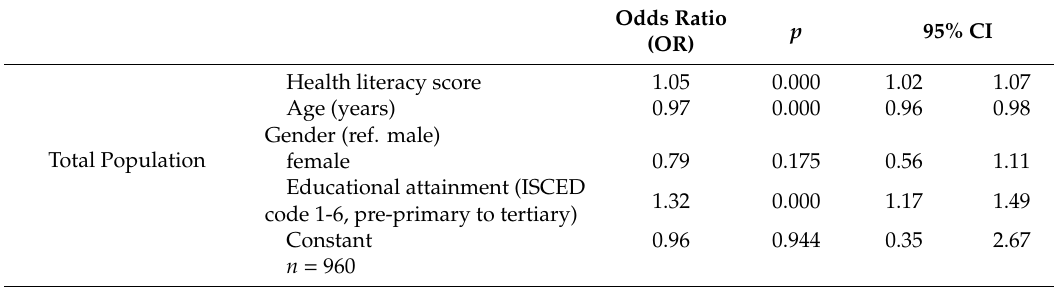
Table A2. Self-rated health status logistic